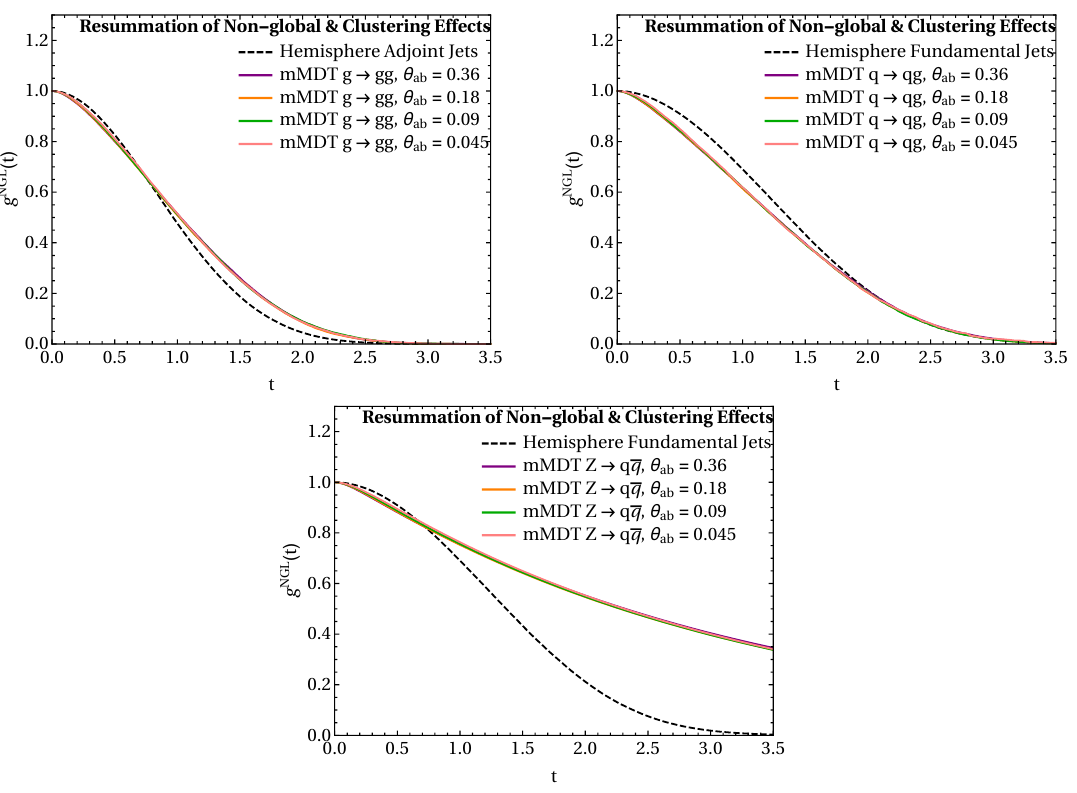
Figure 3 . The resummation of non-global and clustering e(cid:11)ects for modi(cid:12)ed mass drop, with a variety of opening angles and (cid:13)avor structures, as compared to the classical dijet (either e + e (cid:0) ! gg or e + e (cid:0) ! q (cid:22) q ) hemisphere invariant mass NGL